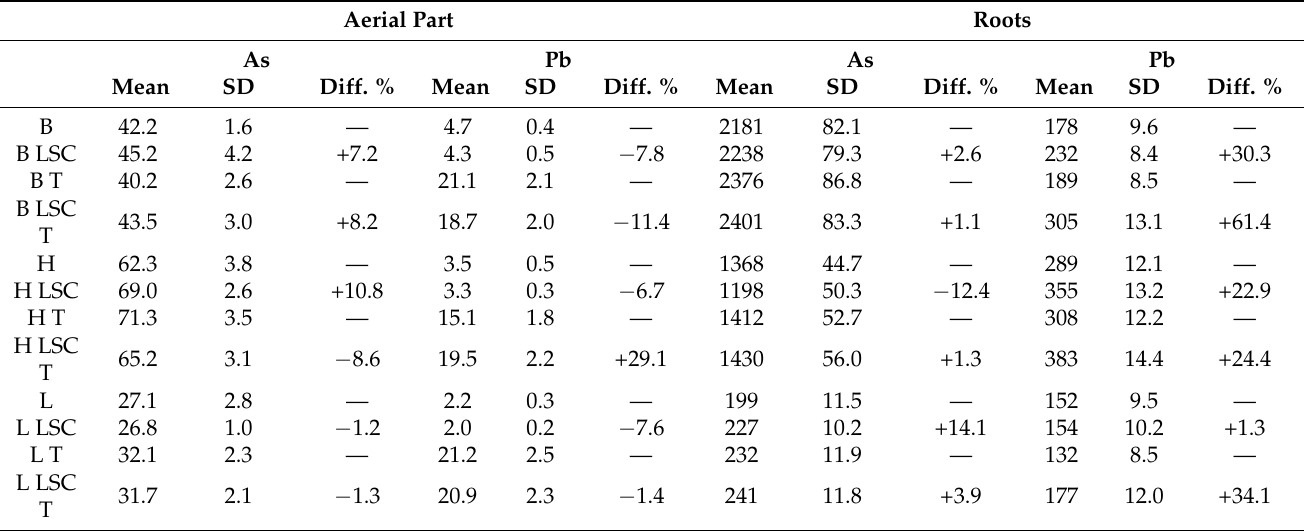
Table 7. Mean concentration values (mg kg − 1 ) of As and Pb absorbed by the plants. Values are reported as mean ± standard deviation (SD). Aerial Part